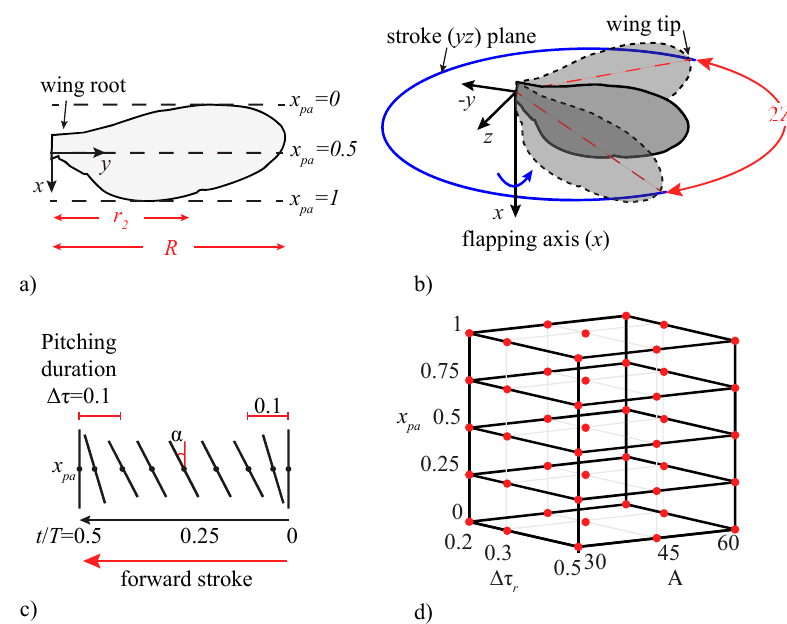
Figure 1. Schematic of the ( a ) wing geometry, ( b ) orthographic view of the flapping wing motion, ( c ) 2D view of the pitching motion for ∆ τ r = 0.2, and ( d ) 3D design space with the design variables, pitch amplitude A, pitching duration ∆ τ r and pitching axis location x pa along the chord.